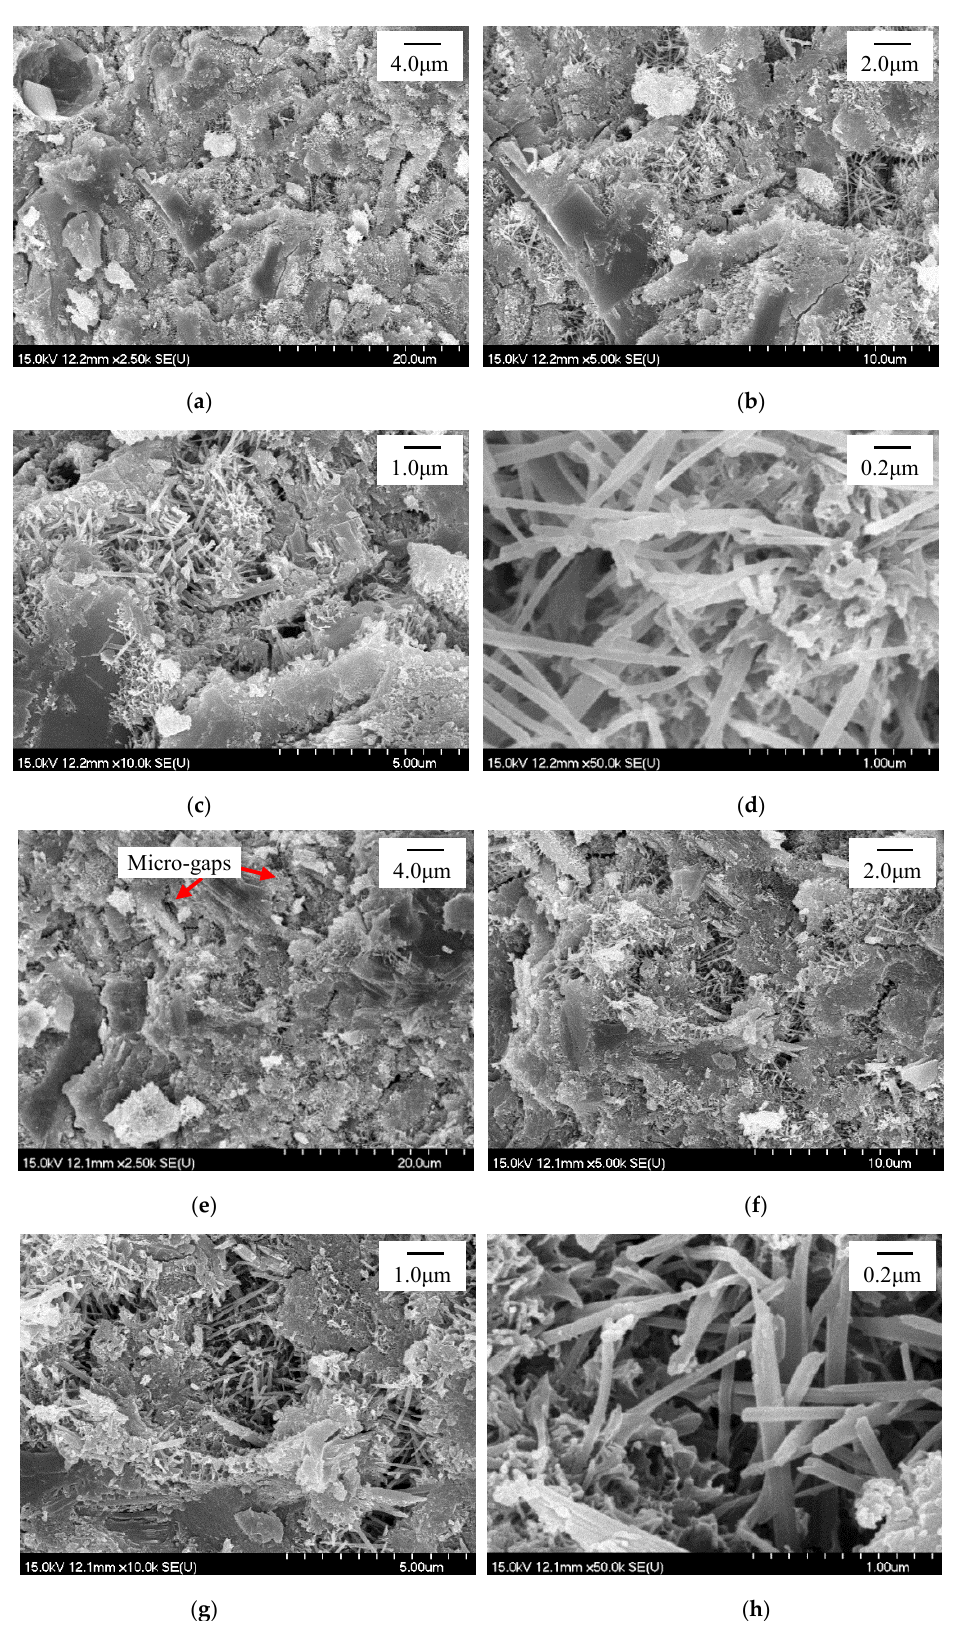
Figure 13. SEM photographs for the HCP with 0.2 wt.% Sucrose at T2 and T3. ( a )–( d ) T2, ( e )–( h ) T3.